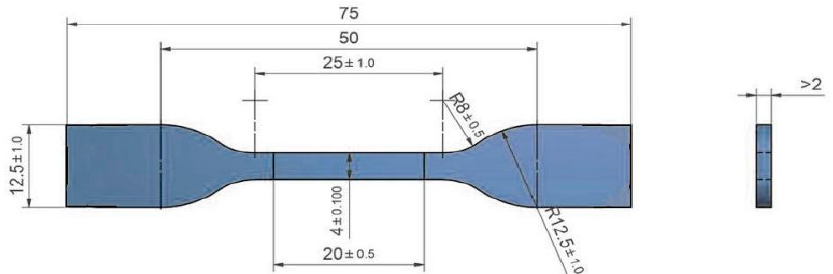
Figure 4. Schematic drawing with dimensions of 3D printed samples for mechanical tests according to ISO 527-2 standard.